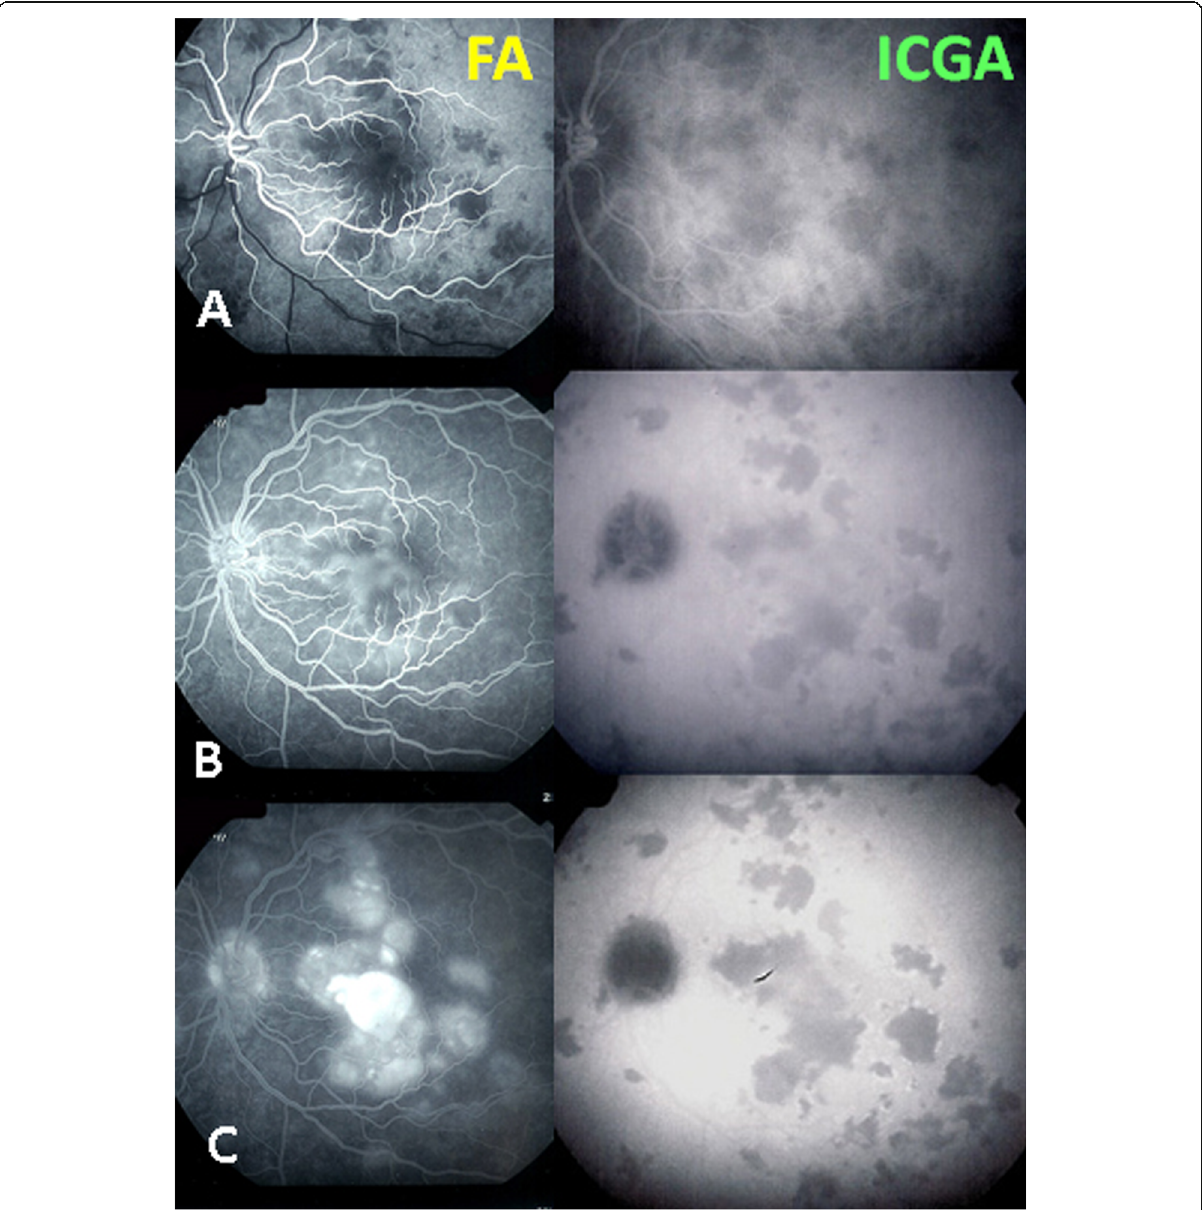
Fig. 10 Parallel FA/ICGA analysis of APMPPE, retinal pooling caused by choriocapillaris non-perfusion induced retinal ischaemia. (A) early phases of FA and ICGA both showing non-perfusion. (B) Intermediate phases of FA and ICGA showing persistent non-perfusion in ICGA (right frame) and beginning of pooling in FA (left frame). (C) late phases of FA and ICGA still showing non-perfusion in ICGA (right frame) and massive pooling in FA (left